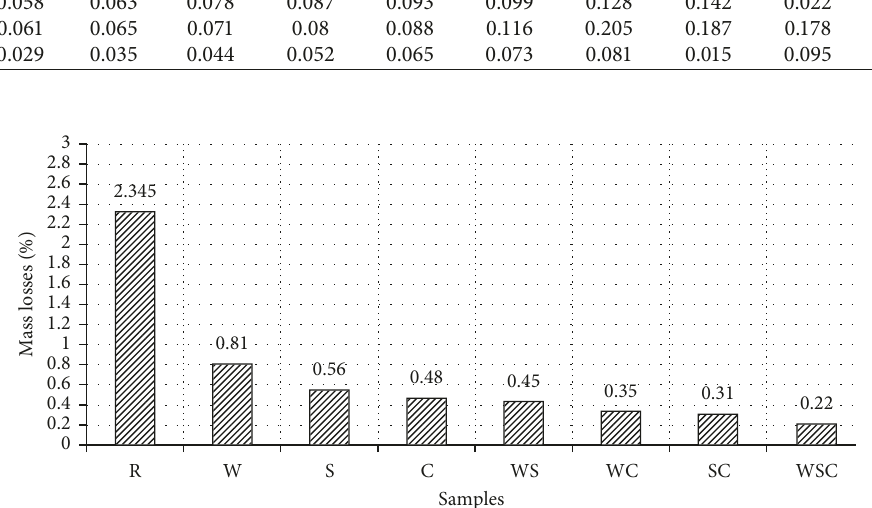
Figure 4: Mass losses of the reinforced concrete samples kept in NaCl solution.